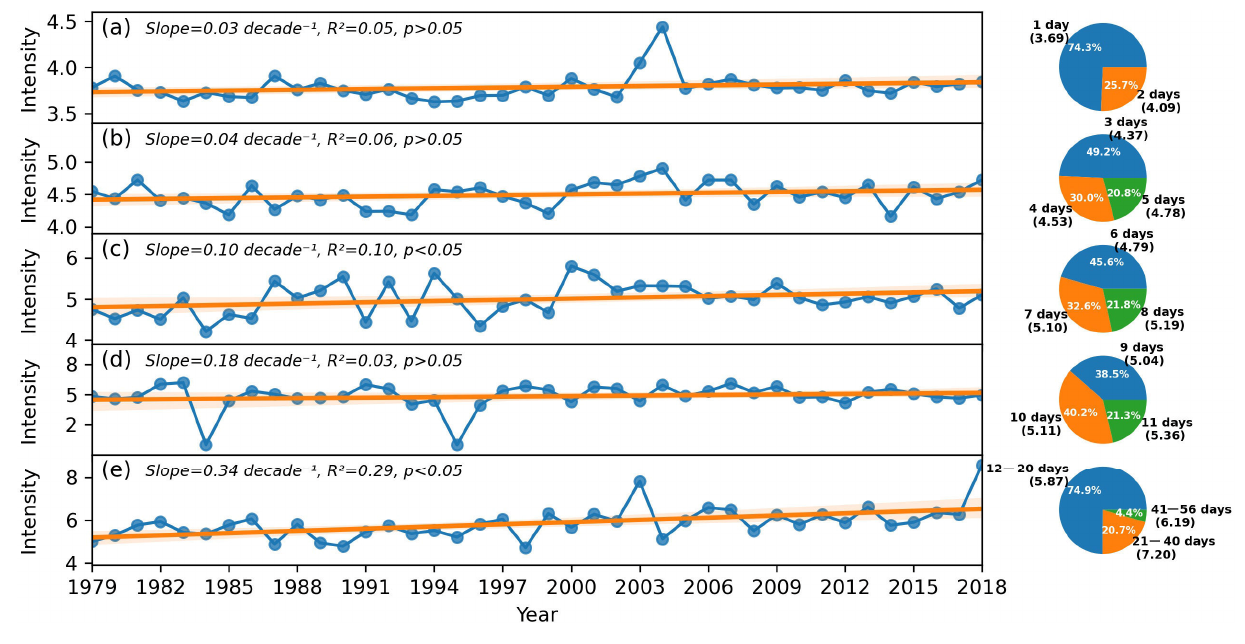
Figure 8. Variations in heatwave event intensity in the 1979–2018 period across China for different durations. ( a ) 1–2 days, ( b ) 3–5 days, ( c ) 6–8 days, ( d ) 9–11 days, and ( e ) more than 12 days. The pie charts on the right represent the percentage of individual duration frequency to total frequency for current all durations in the 1979–2018 period, and the values in brackets are the mean intensity for the corresponding duration between 1979 and 2018.